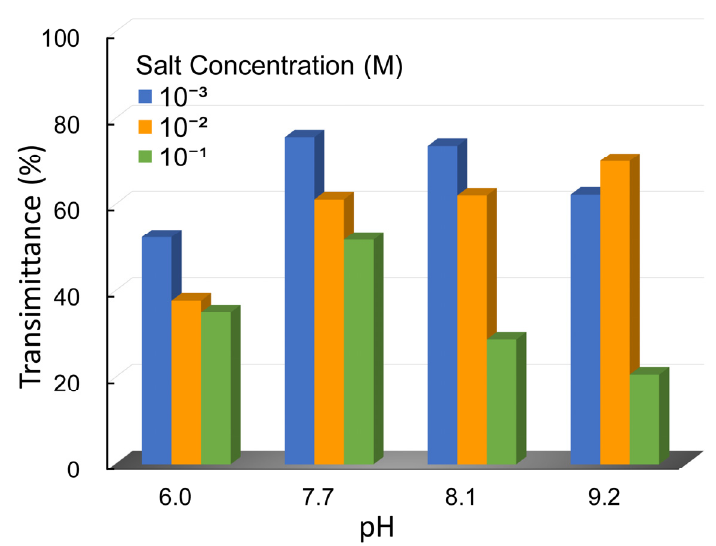
Figure 7. Photos of the Na-Mt suspensions taken after settling for 12 h under different NaCl